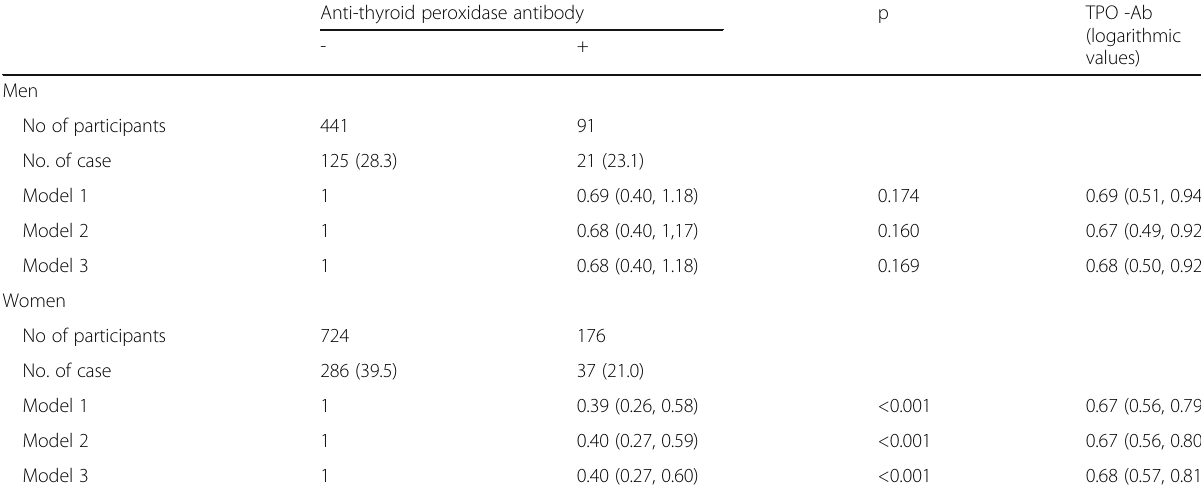
Table 4 Sex-specific odds ratios (ORs) and 95% confidence intervals (CIs) for thyroid cyst in relation to anti-thyroid peroxidase antibody (TPO-Ab) Anti-thyroid peroxidase antibody values)-